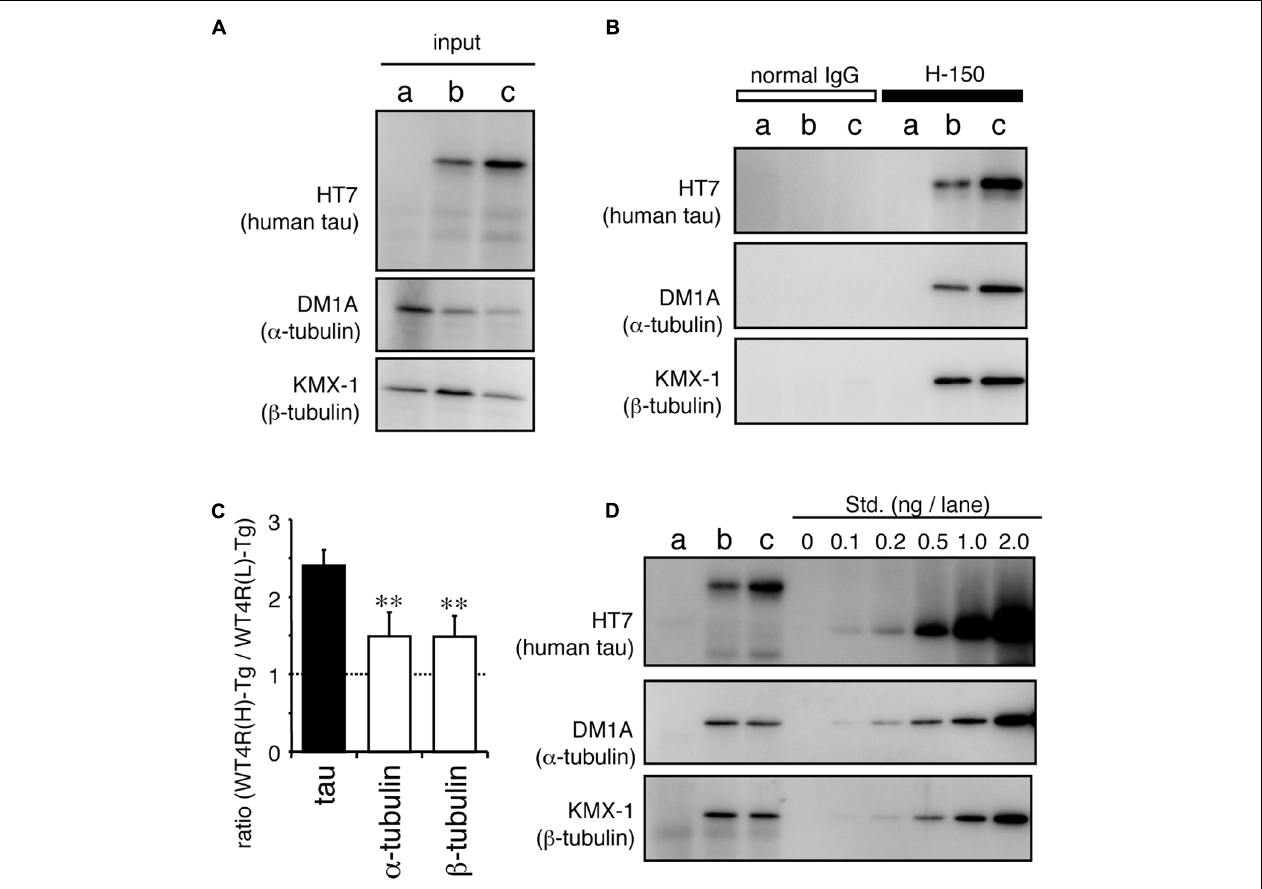
FIGURE 7 | MT-unbound tau in tau-Tg worms interacts with α / β -tubulin dimers in the soluble fraction. MT-unbound soluble fractions were prepared from Mock-Tg (a) , WT4R(L)-Tg (b) , and WT4R(H)-Tg (c) worms and subjected to the immunoprecipitation using anti-tau IgG (H-150). (A) Expression of tau, α -tubulin, and α -actin in the total lysate (input) are shown. (B) Immunoprecipitated proteins were analyzed using anti-tau (HT7), anti- α -tubulin (DM1A), and anti- β -tubulin (KMX-1) antibodies. (C) Relative amount of tau and α / β -tubulin in the co-immunoprecipitaed fraction from tau-Tg worms were quantified (mean ± SEM, n = 6). (D) Quantitative analysis of each protein indicates that the nearly equal amount of α - and β -tubulin were co-immunoprecipitated with tau. Std. indicates the purified recombinant tau (for HT7) or porcine tubulins (for DM1A and KMX-1). Statistical significance was analyzed by Tukey’s post hoc test ( ∗∗ p < 0.01 ).